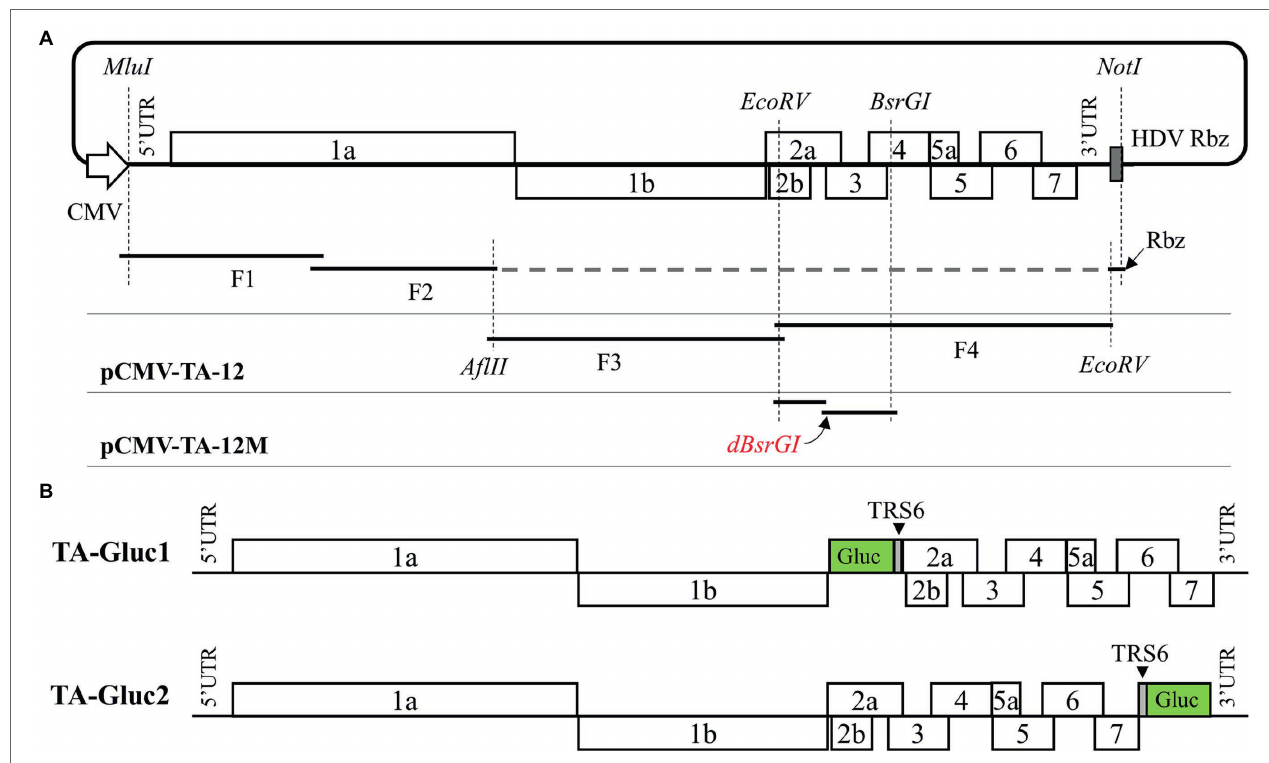
FIGURE 1 | Construction of an infectious cDNA clone of HP-PRRSV TA-12 strain and the reporter viruses expressing a Gluc. (A) An infectious cDNA clone of TA- 12 assembled through homologous recombination in vitro as described in the “Materials and Methods.” (B) Two cDNA clones were designed to express a Gluc via two strategies, respectively. In TA-Gluc1 construct the Gluc coding sequence followed by a PRRSV TRS6 was inserted into pCMV-TA-12 M between ORF1b and ORF2a, while in TA-Gluc2 construct a PRRSV TRS6 followed by the Gluc coding sequence was inserted between ORF7 and 3 ′